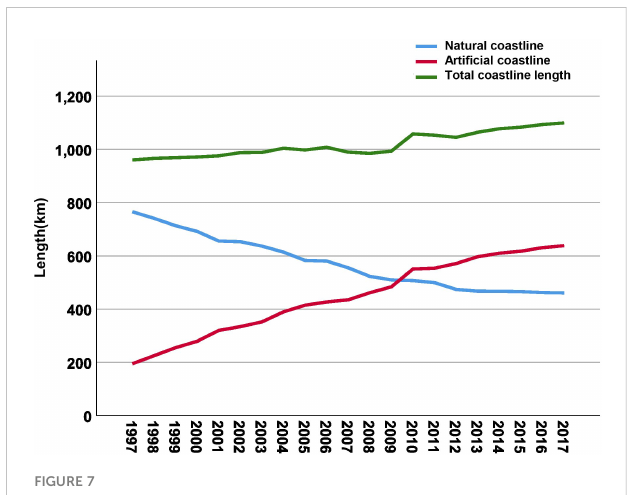
FIGURE 7 Changes in coastline length from 1997 to